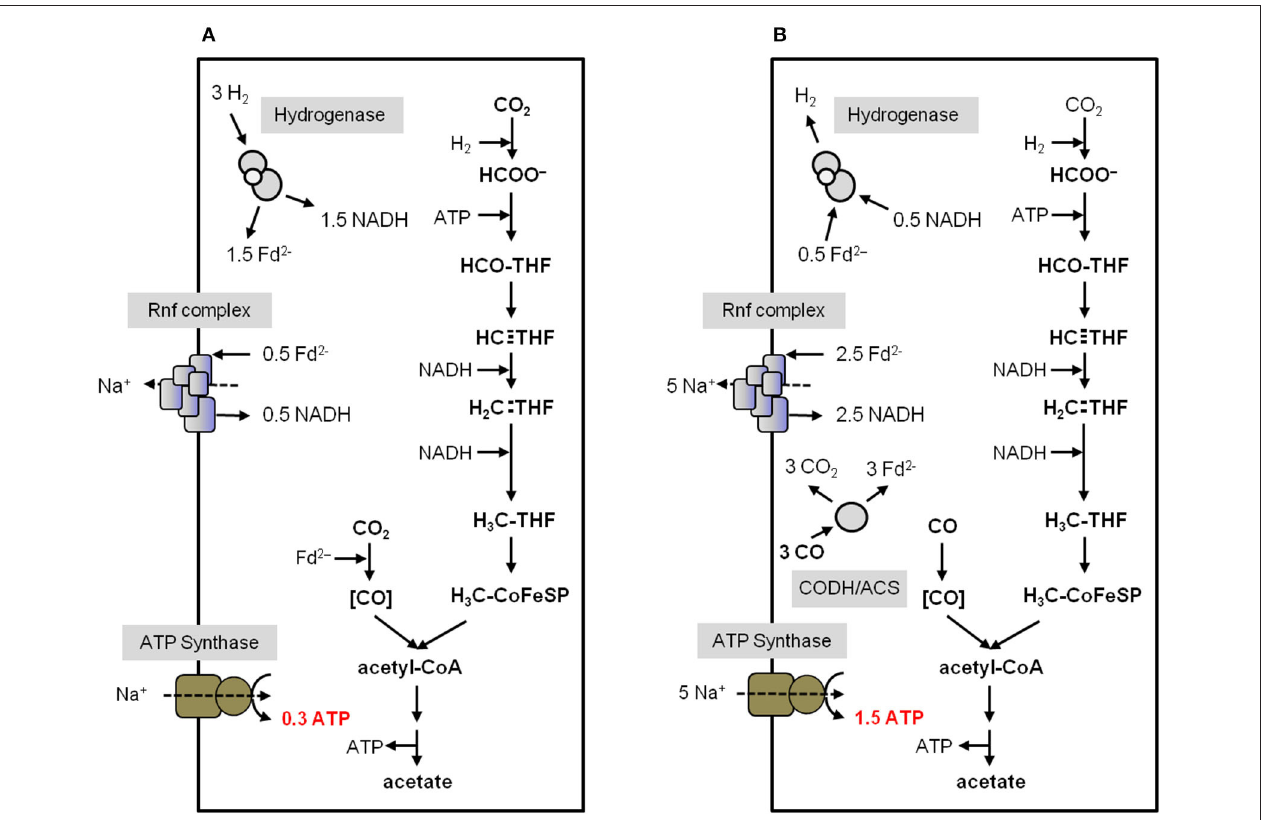
FIGURE 4 | Bioenergetics of acetate formation from H 2 + CO 2 and CO in A. woodii . The reducing equivalents for the reductive steps in the WLP (A) are provided by an H 2 -oxidizing, electron-bifurcating hydrogenase which reduces ferredoxin and NAD + . The reducing equivalents for the reductive steps during CO oxidation (B) are provided by the CO-oxidizing CODH/ACS which reduces ferredoxin. Excess Fd 2 − is oxidized by the Rnf complex which reduces NAD + and builds up a Na +